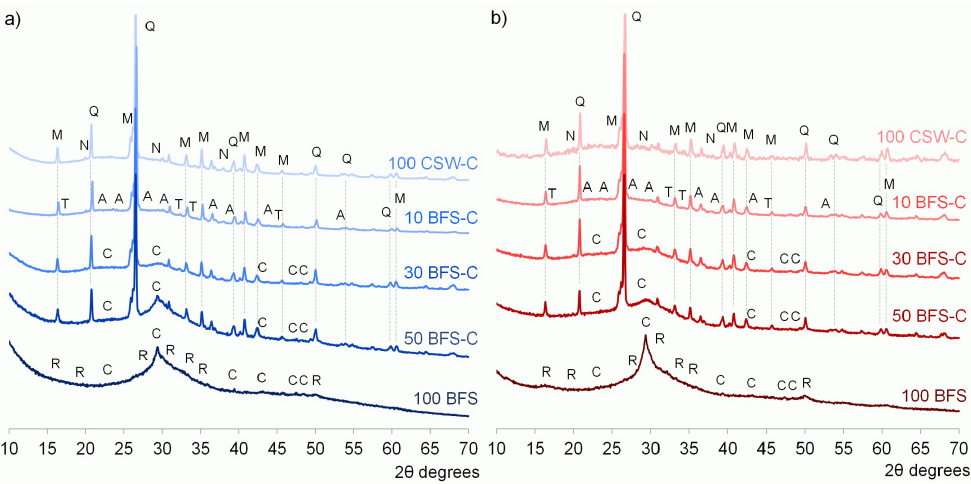
Figure 7. The XRD spectra for the CSW/BFS blended pastes that contained 4 wt % Ca(OH) 2 and prepared with 10, 30 and 50 wt % BFS, cured at: ( a ) 20 °C for 28 days; ( b ) 65 °C for 7 days. Quartz (Q, SiO 2 ); Mullite (M, Al 6 Si 2 O 13 ); Calcite (C, CaCO 3 ); Anorthite (A, CaAl 2 Si 2 O 8 ); Natron (N, Na 2 CO 3 ·10H 2 O); Rankinite (R, Ca 3 Si 2 O 7 ); Thermonatrite (T, Na 2 CO 3 ·H 2 O).